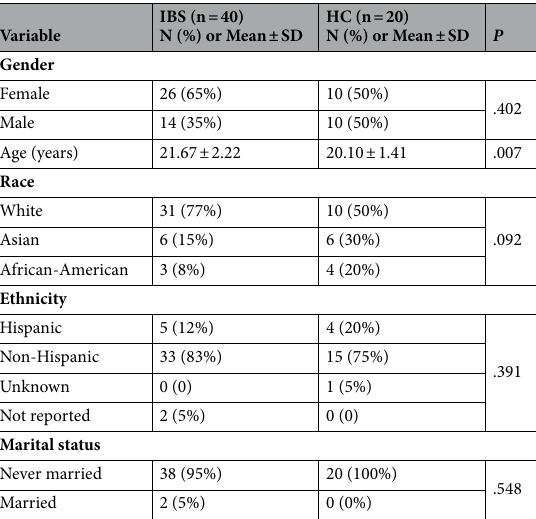
Table 1. Demographic characteristics of the participants. IBS, irritable bowel syndrome; HC, healthy